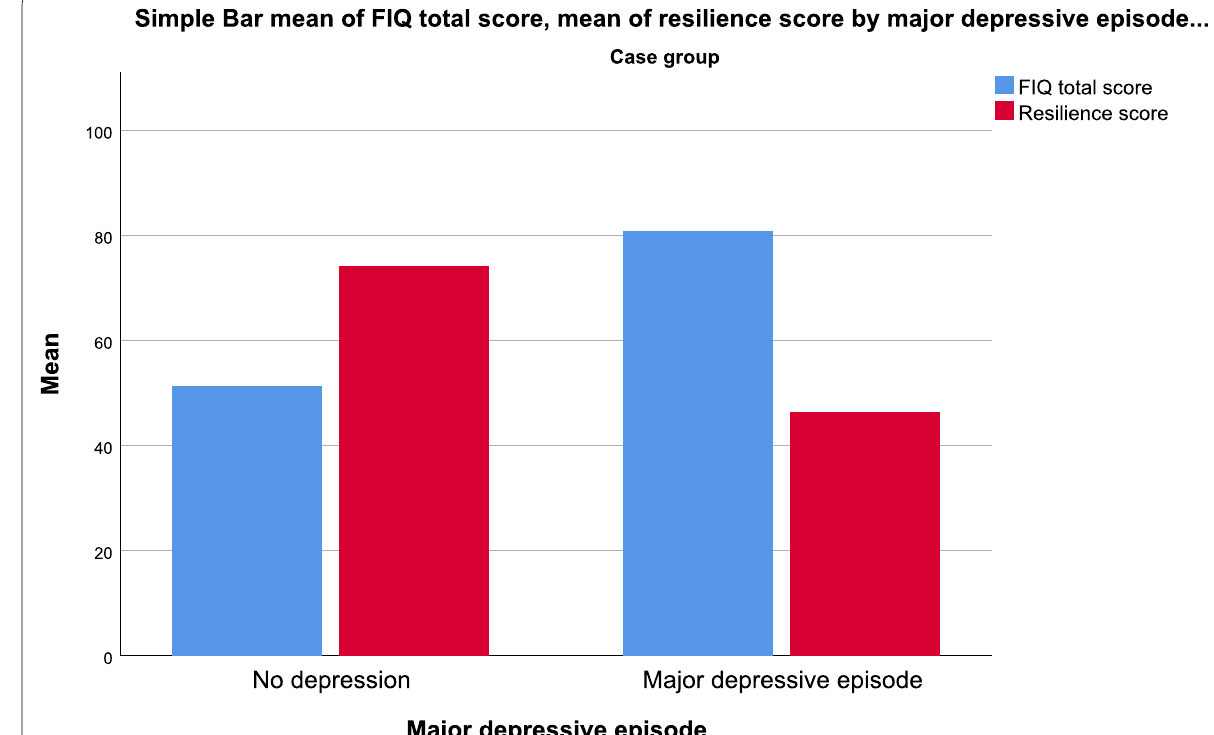
Fig. 1 Bar graph showing that fibromyalgia patients with major depressive disorder had low resilience and higher disease severity in comparison to those without major depressive disorder using the Kruskal-Wallis test ( P =